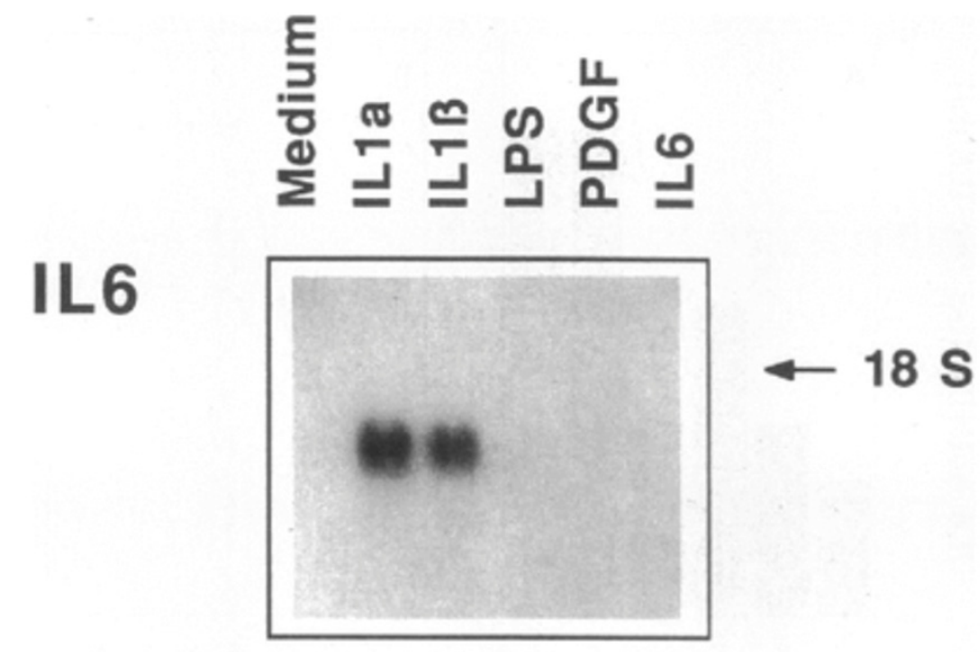
Figure 5. IL-1 induces IL-6, a further amplification of cytokine signaling. This Northern blot shows the expression of the messenger RNA encoding interleukin-6 in human smooth muscle cells incubated with interleukin-1 isoforms, bacterial lipopolysaccharide (LPS), platelet-derived growth factor (PDGF) or IL-1 itself. IL-1 strongly induces IL-6 messenger RNA and in other experiments not shown induced IL-6 protein synthesis as shown by metabolic labeling and biological activity as determined by thymidine incorporation by B9 cells. From J Clin Invest 85:731-738, 1990.